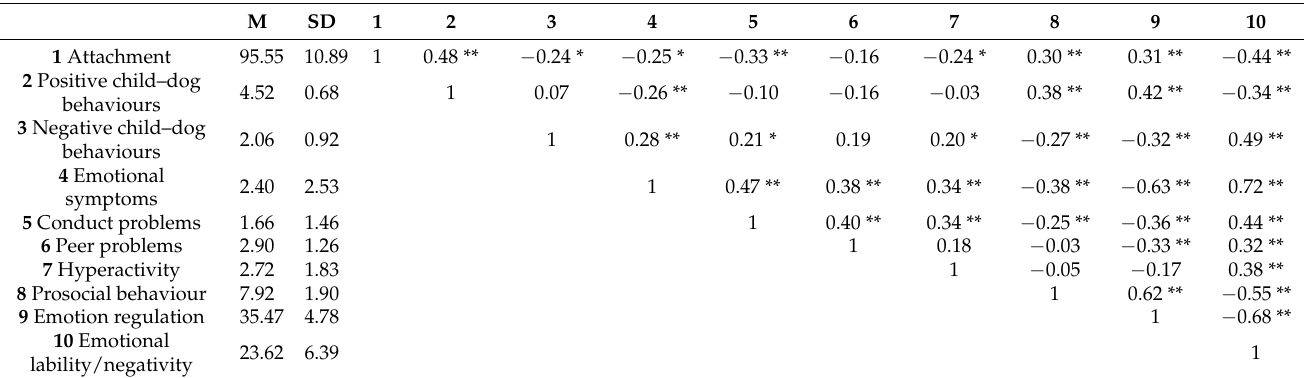
Table 5. Descriptive statistics and intercorrelations among main study